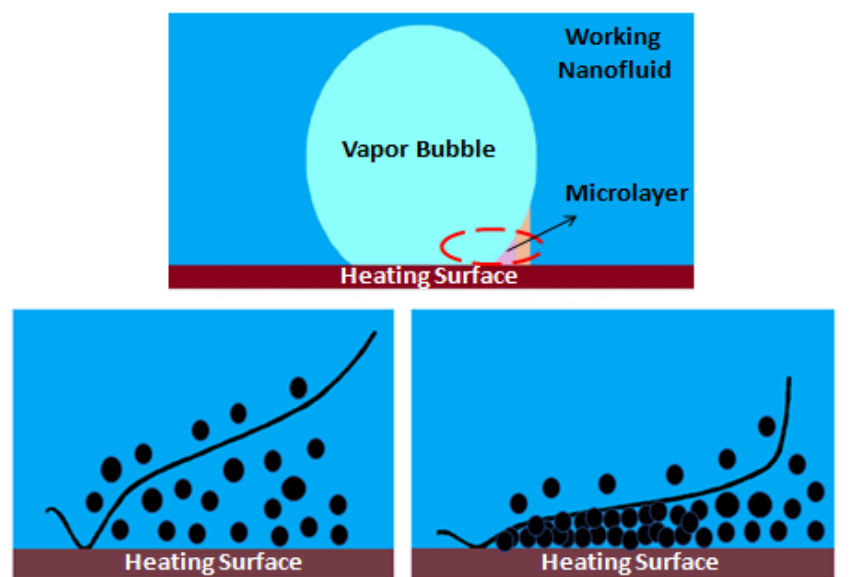
Figure 2. Schematic representation of the nanoparticle deposition in the vapor bubble microlayer. Adapted from [42].